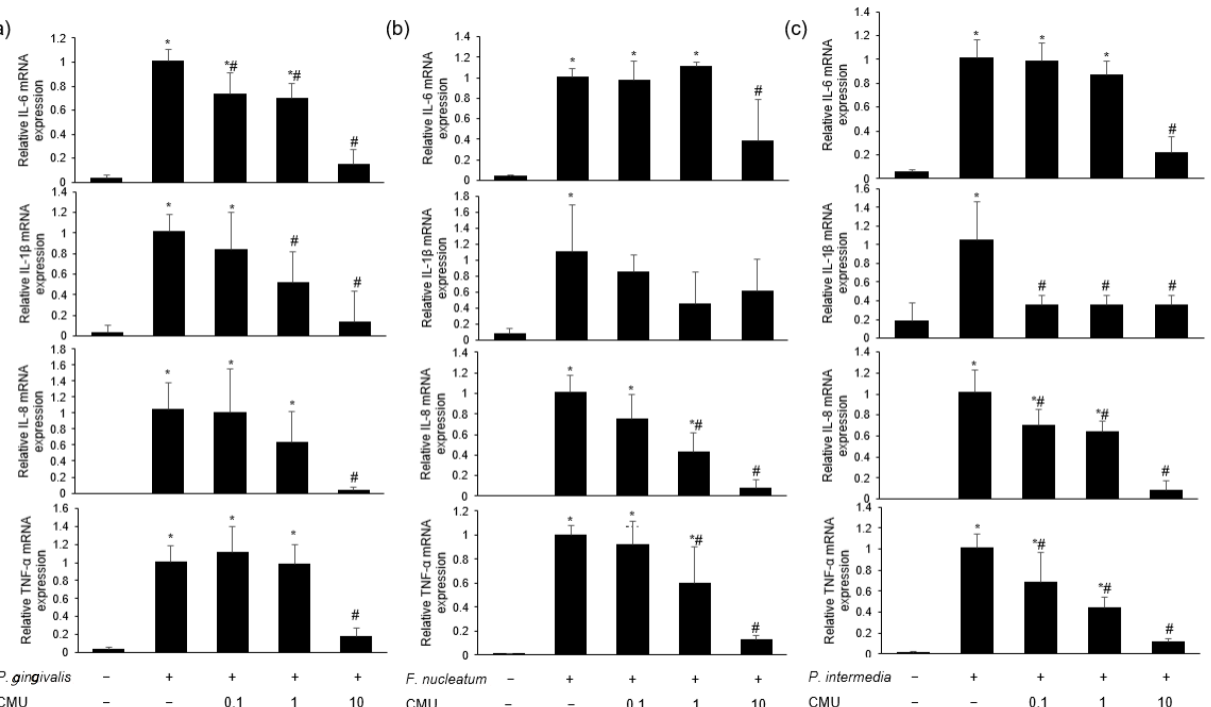
Figure 5. Dose-dependent effects of W. cibaria CMU on the mRNA expression of pro-inflammatory cytokines stimulated by P. gingivalis ( a ), F. nucleatum ( b ), and P. intermedia ( c ). HGFs were pre- treated with W. cibaria CMU for 30 min at various doses (0.1, 1, and 10) and then incubated with each periodontal pathogen (MOI = 100) for 4 h. CMU, W. cibaria CMU. Data are presented as the mean ± standard deviation. * p < 0.05, in comparison to the untreated group. # p < 0.05, in comparison to the control